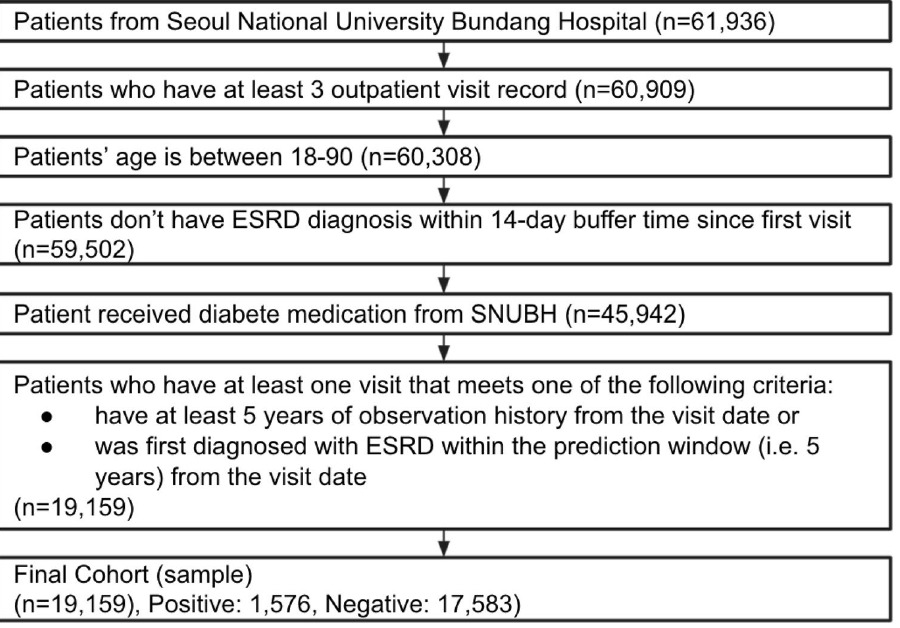
Figure 4. Cohort selection. ESRD end-stage renal disease, SNUBH Seoul National University Bundang